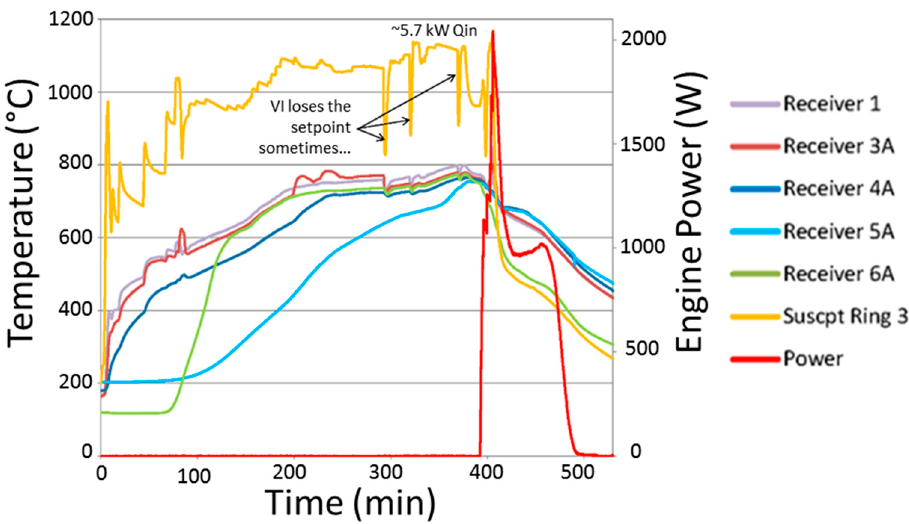
Figure 12. Horizontal TES testing results. VI: virtual instrument.